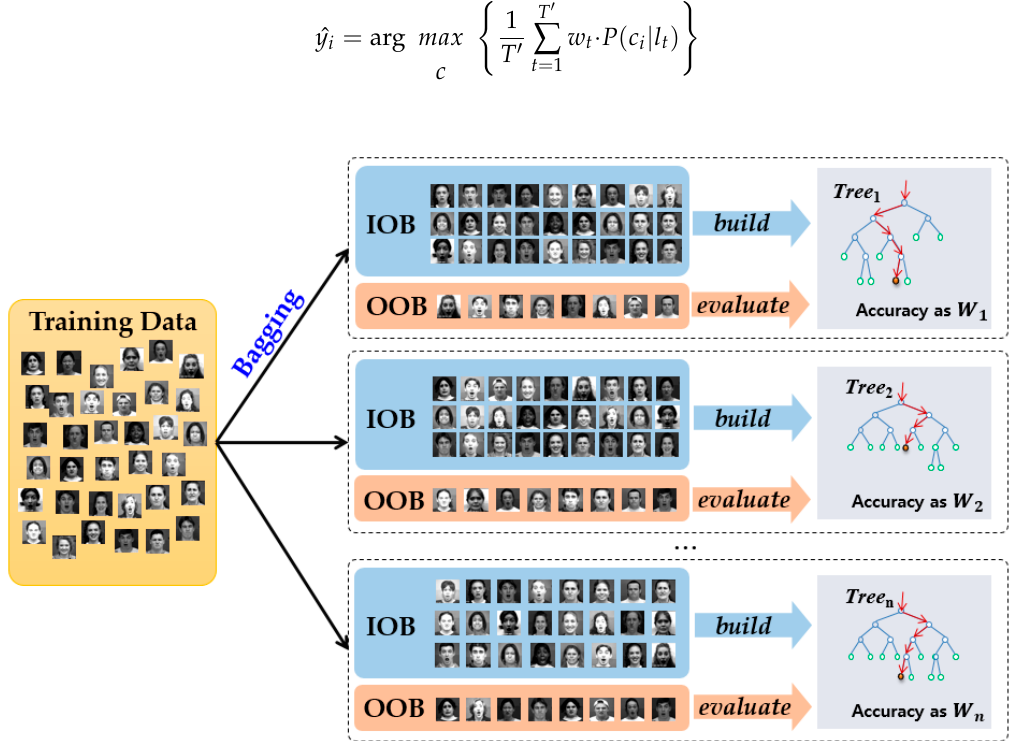
Figure 4. Training process of weight random forest using “in-of-bag” (IOB) and “out-of-bag” (OOB).